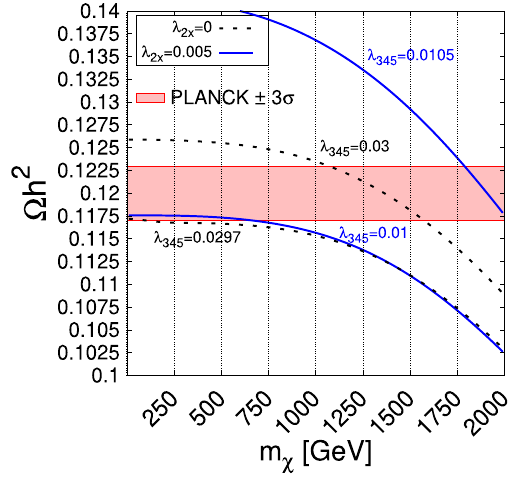
Fig. 8 RelicdensityasafunctionoftheDMcandidatemassfor λ 345 = 0 . 0297 , 0 . 03 (0 . 01 , 0 . 0105) with λ 2 x = 0 ( λ 2 x = 0 .